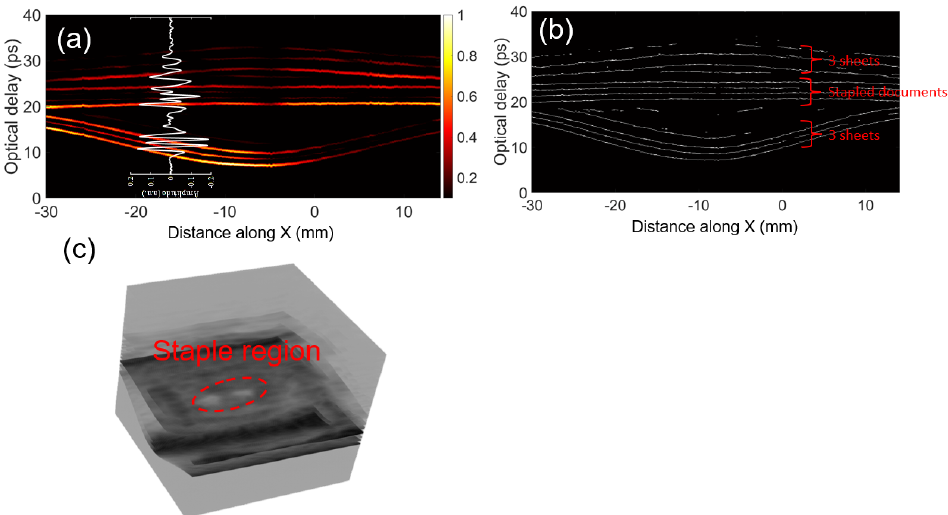
Figure 7. ( a ) B-scan through a cross section through the s = 10 stack containing a stapled document along the dashed line shown in Figure 5a with an example of the FWDD reconstructed signal at the position indicated. Large air gaps above and below the stapled sheets are evident. The color scale is linear in the amplitude of the reflected THz signal. Thus, yellow indicates a strong reflection, red a moderate reflection, etc. ( b ) shows the corresponding binary THz B-scan based on the FWDD reconstruction. ( c ) Three-dimensional rendering of THz TOFT data to emphasize the staple